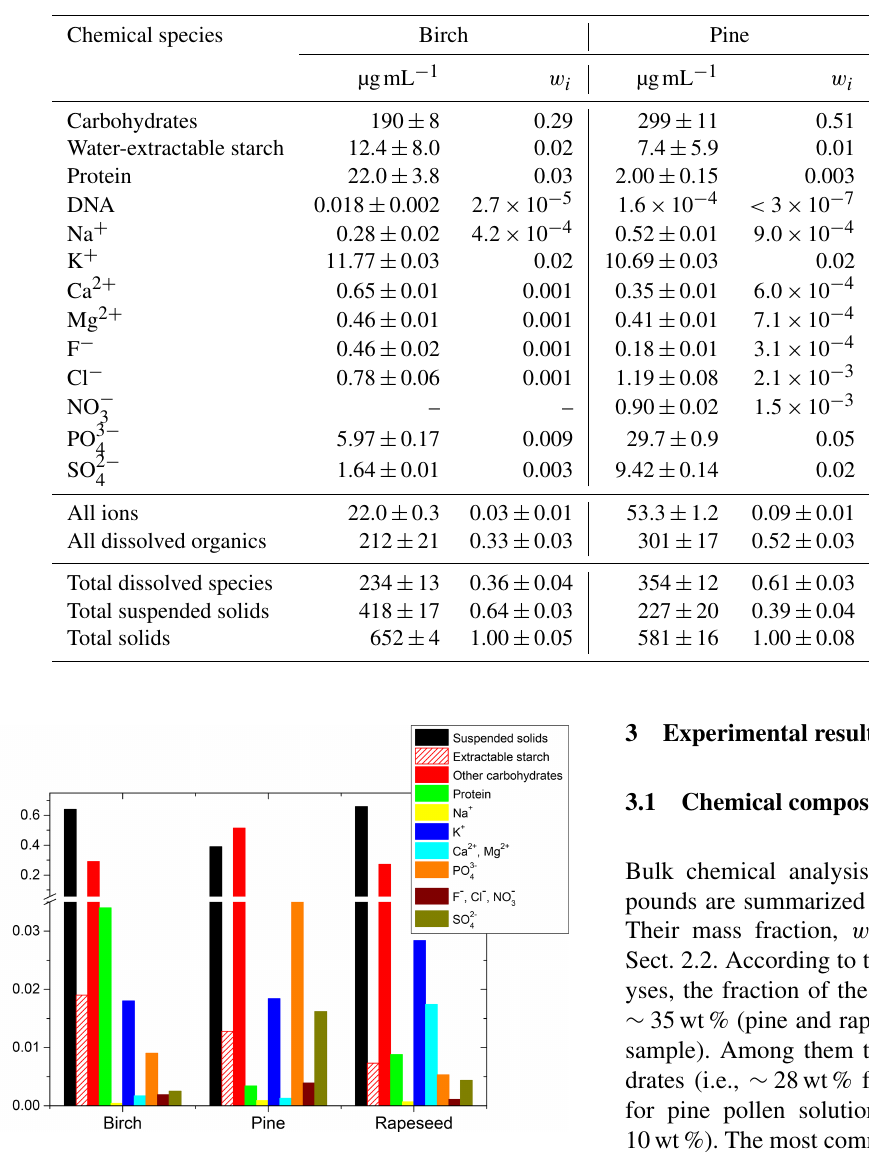
Table 1. Concentration (µgmL − 1 ) and mass fraction ( w i ) of chemical species ( i ) in the filtered solution of pollen grains. Total solids is the sum of the total dissolved species and total suspended solids. w i is the ratio of the amount of selected species to the mass of total solids containing 1mL of water.